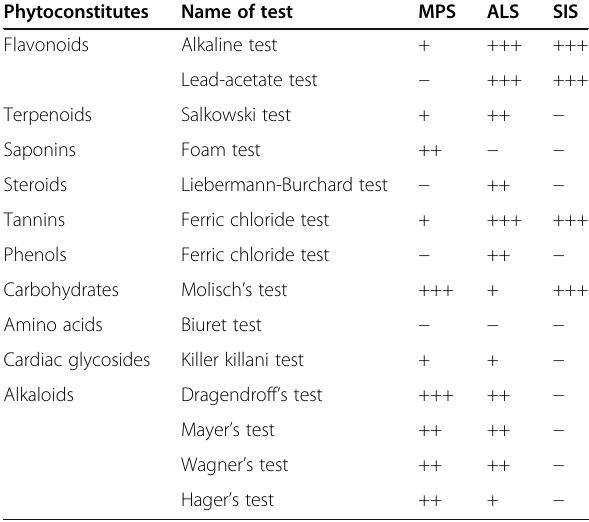
Table 1 Phytochemical profile of all three plant extracts Phytoconstitutes